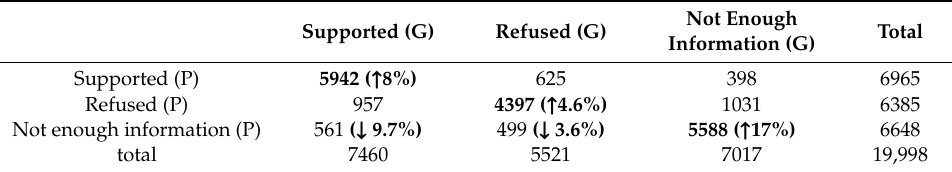
Table 2. Confusion matrix on the FEVER dev